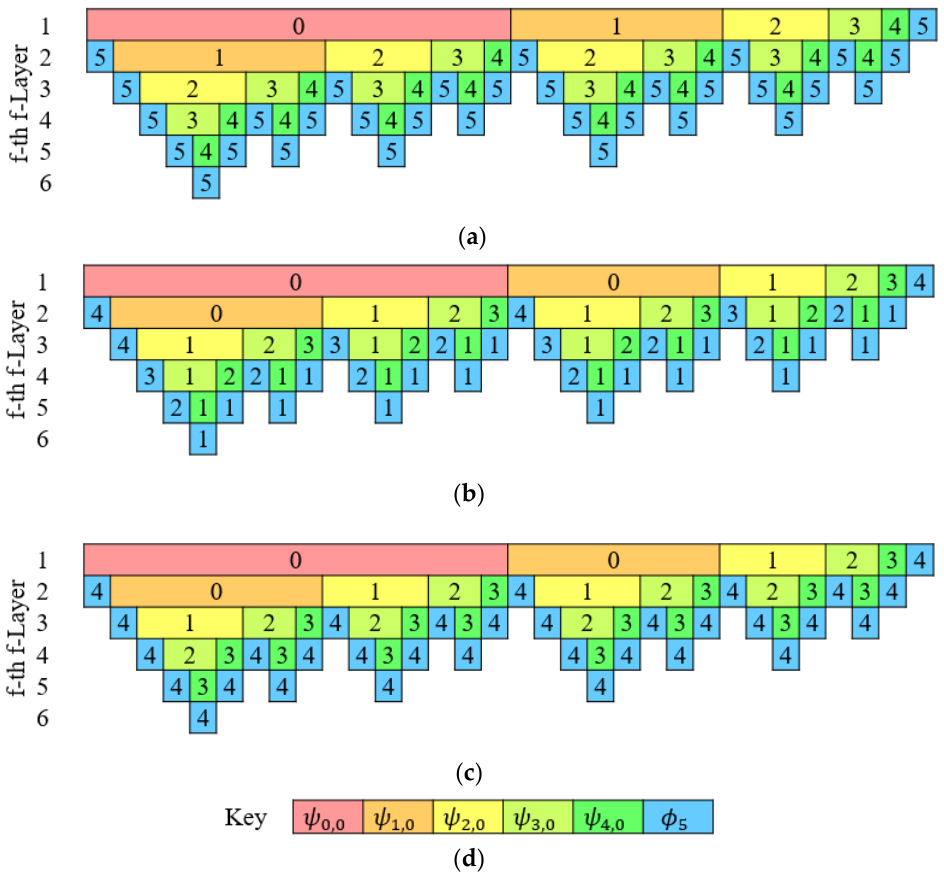
Figure 4. Example of a quantization scheme for a WSN with J = 5 and L = 1 at the input of each and filter for all possible s-layers in the network: ( a ) filter scales ψ λ and φ J ; ( b ) Log 2 subsampling rate d f ; ( c ) cumulative log 2 subsampling rate r j = ∑ d f ; ( d ) color key for filter scales. outputs from an s-layer are derived in the following two